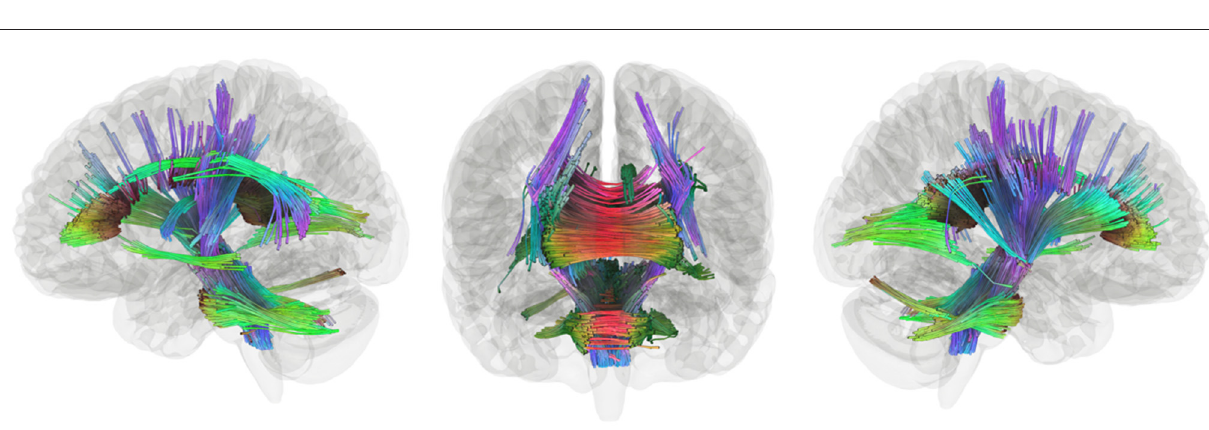
EPT-HLD groups, but not for the TC group.